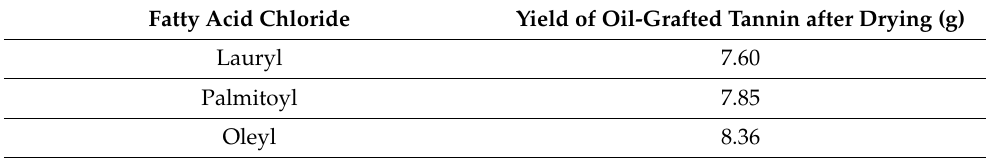
Table 2. Yield of oil-grafted tannins using different fatty acid chlorides.